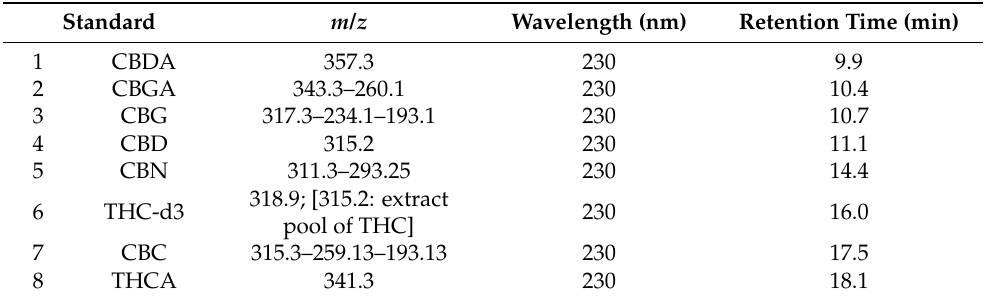
Table 6. Mass to charge ratios ( m/z ) and retention times related to the investigated terpenophenolic